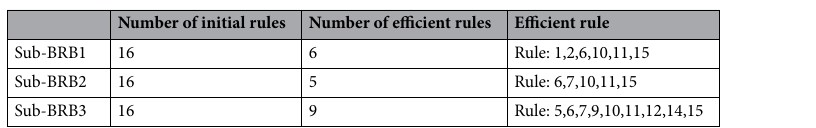
Table 3. The number of DBRB-I model